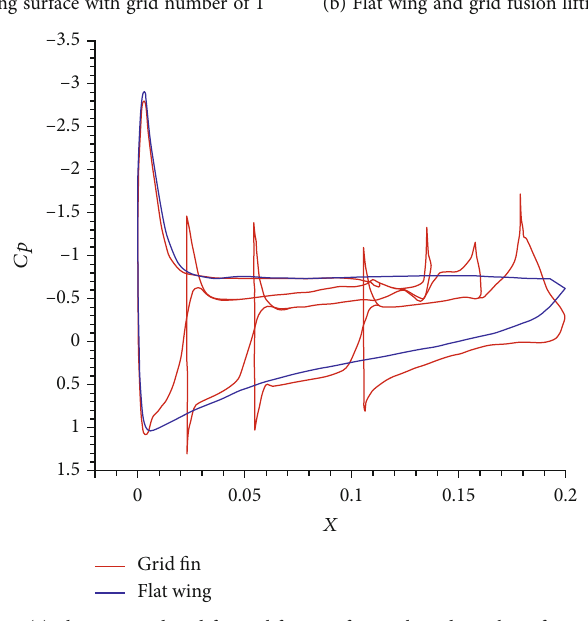
Figure 23: Pressure coe ffi cient diagram of fl at wing and grid fusion lifting surface with di ff erent grid numbers ( Ma = 0 : 6 α = 28 ° z / b = 0 : 75